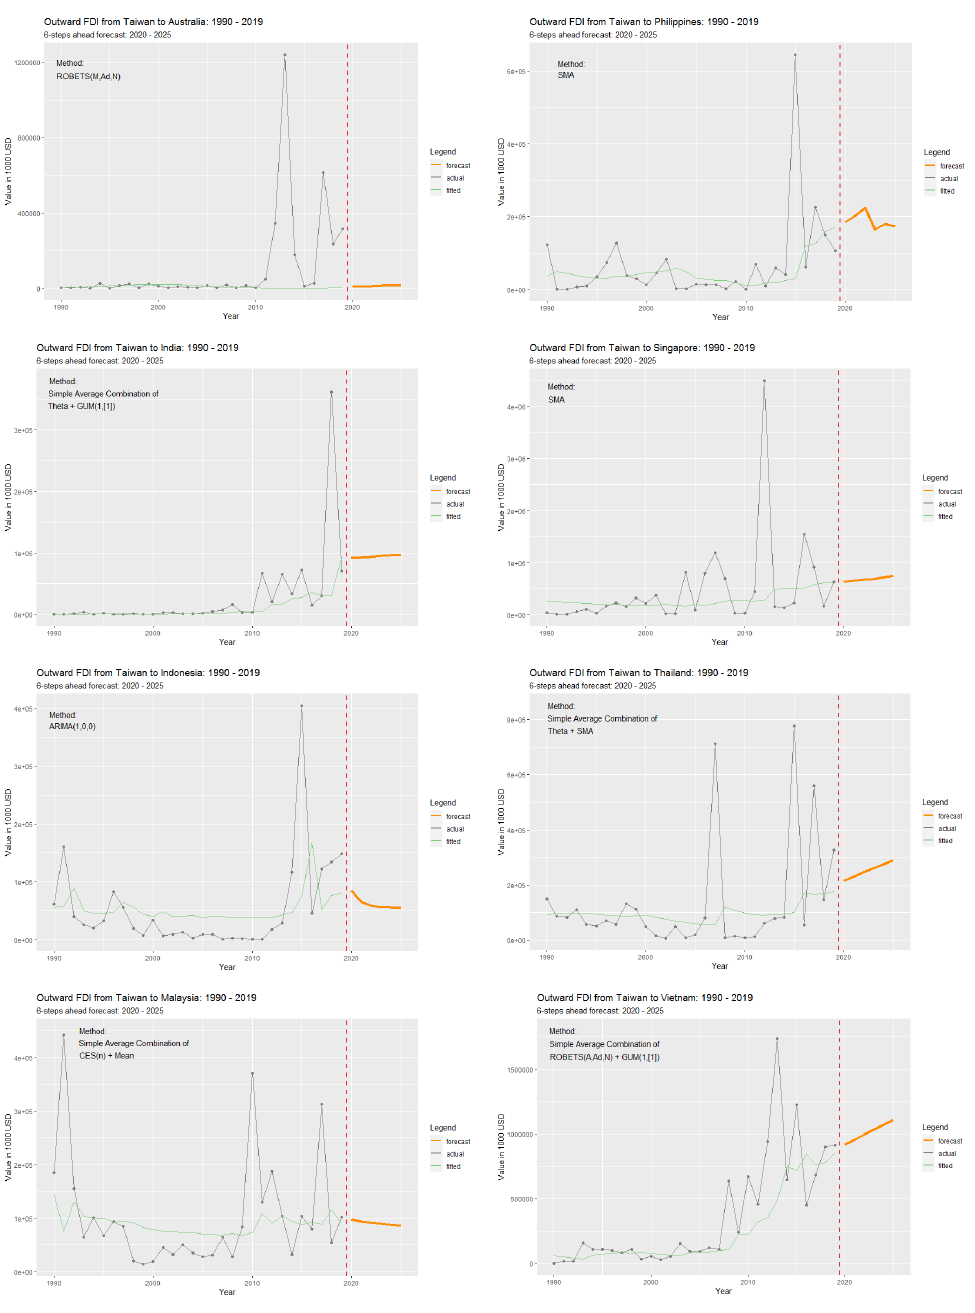
Figure A3. Outward FDI forecasts from Taiwan to eight NSP